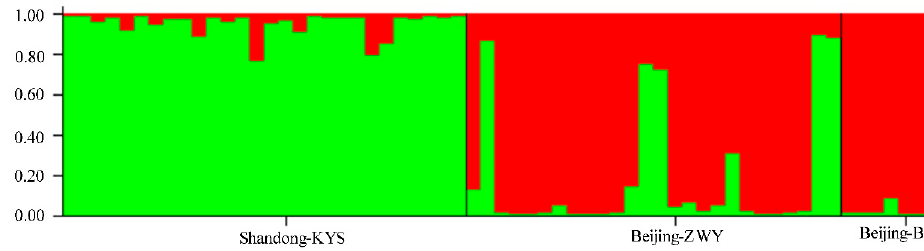
Figure 3. Structure analysis based on microsatellite genotypes among three Bombina orientalis populations.